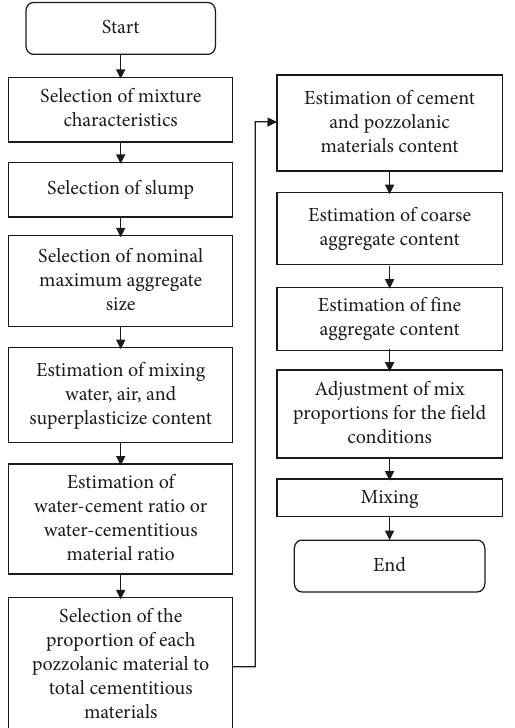
Figure 3: The flow chart of ACI mix design method.